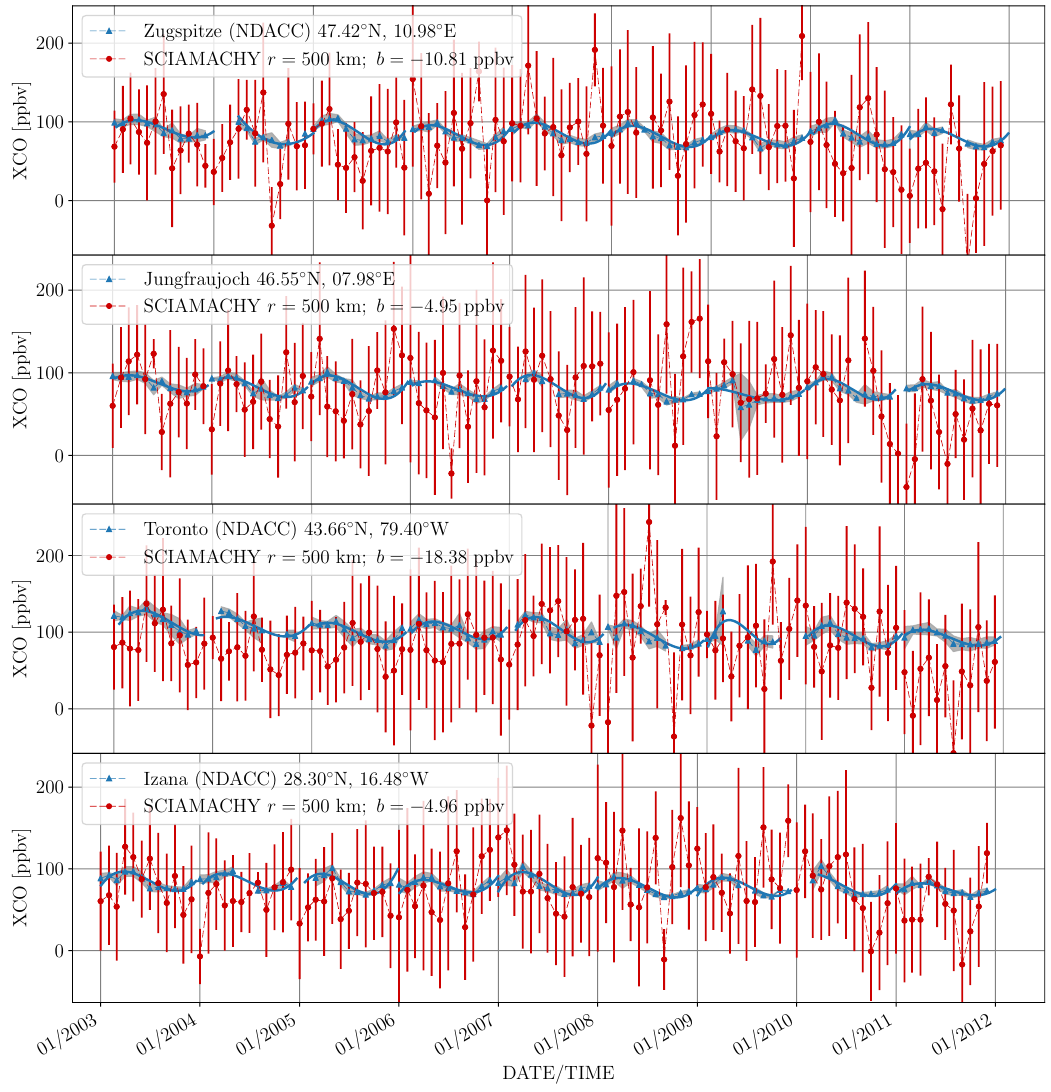
Figure 14. Time series of r − 2 distance weighted monthly-mean xCO dry air column mixing ratios measured by the SCIAMACHY and NDACC stations. The CO mixing ratios were calculated using the surface pressure information per station according to the description in Section 2.1.1. Sites where no such information was available were